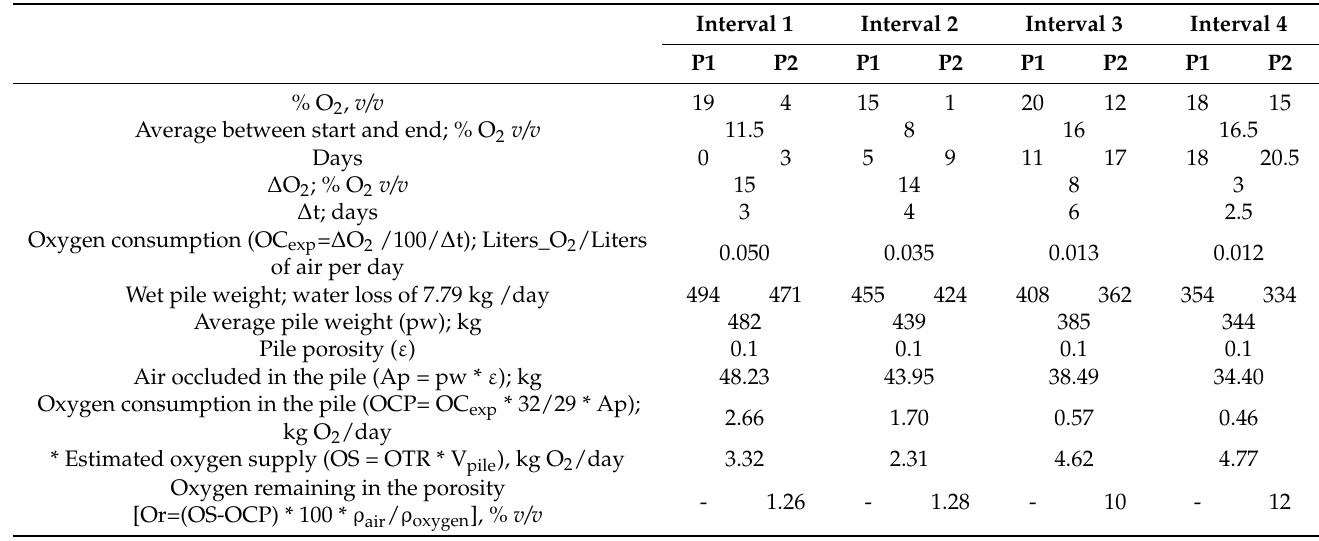
Table 4. Experimental consumption and estimated oxygen supply at 60 cm depth in pile